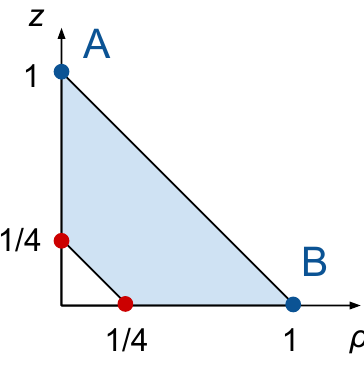
Figure 1 . The orbit space on the ( ρ, z ) plane of the rephasing-invariant version of the A 4 3HDM. Two blue dots correspond to possible neutral minima, which the two read dots correspond to the two possible charge-breaking